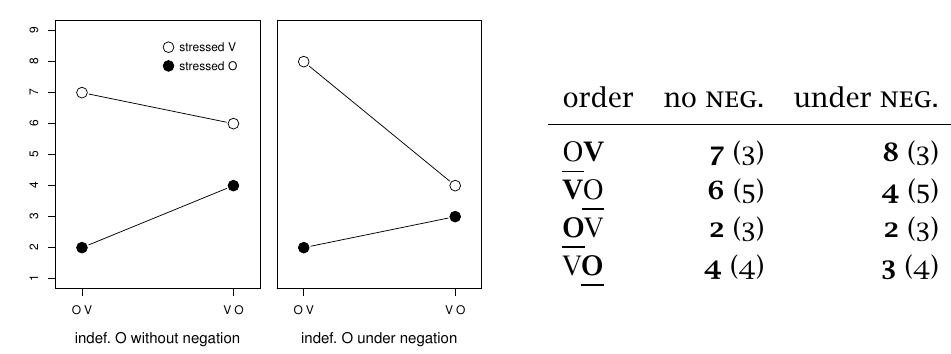
Figure 8 Results of the post-hoc analysis for narrow scope under negation; medians in boldface, IQR in